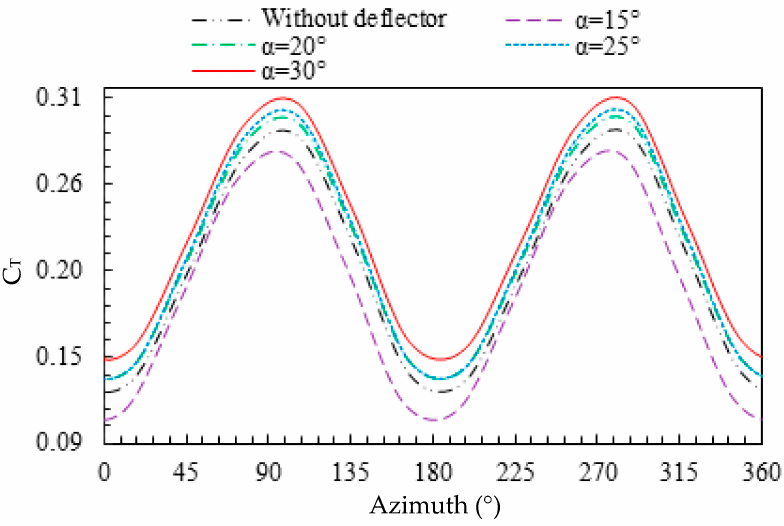
Figure 19. Torque coefficient for different deflection angles.